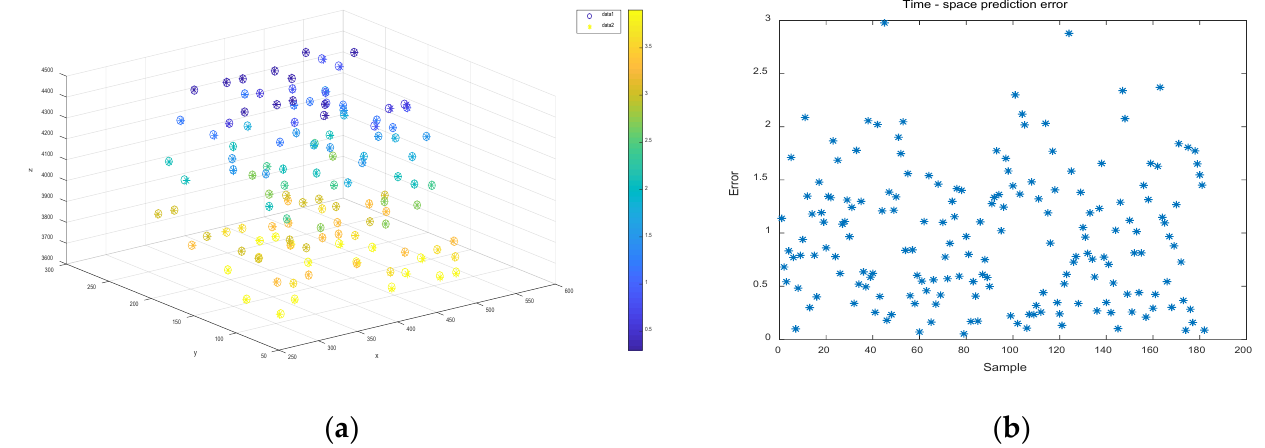
Figure 11. Time-space localization prediction and error of sample points for speed 60 mm/s sample bank test. ( a ) Four-dimensional positioning prediction results; ( b ) spatio-temporal positioning prediction error.